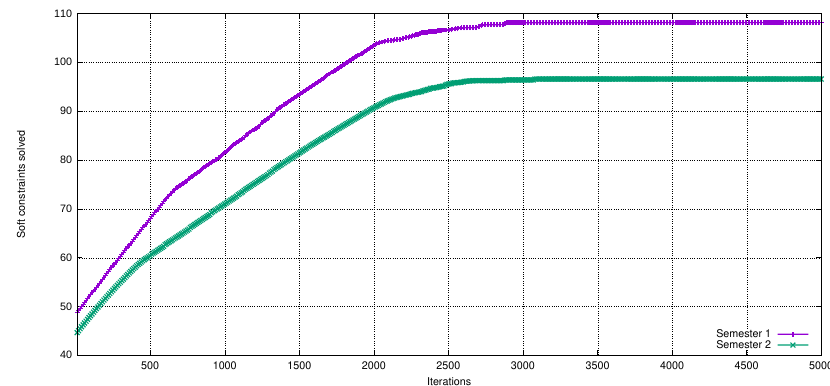
Figure 17. the satisfaction of soft constraints in the ACA phase.